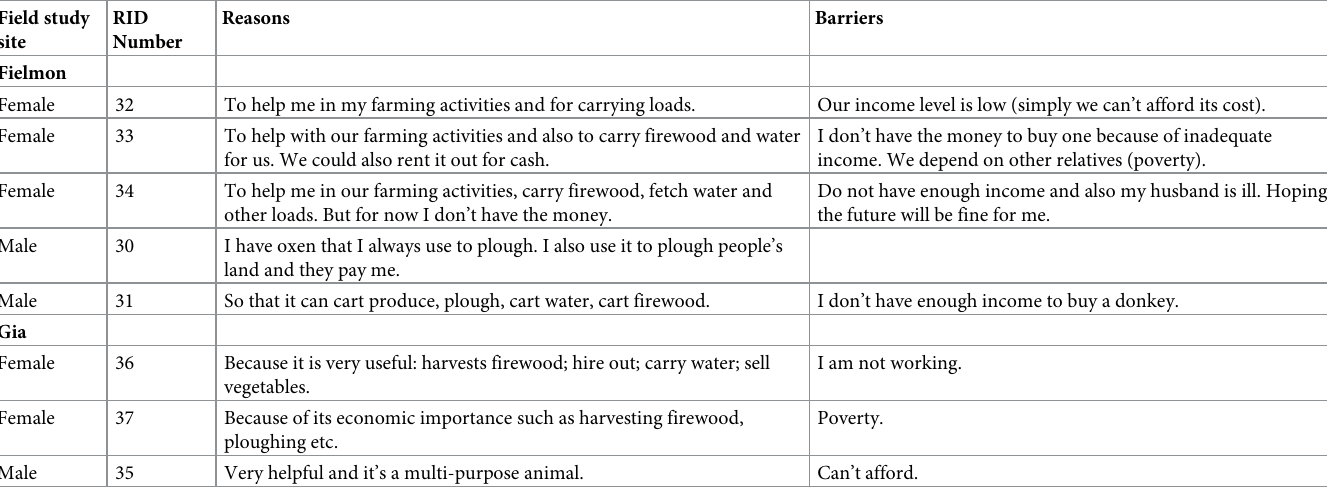
Table 4. Reasons why NDO survey respondents would like to buy a donkey and barriers to donkey ownership (n = 8). Source: Maggs, 2022 [1]. Field study